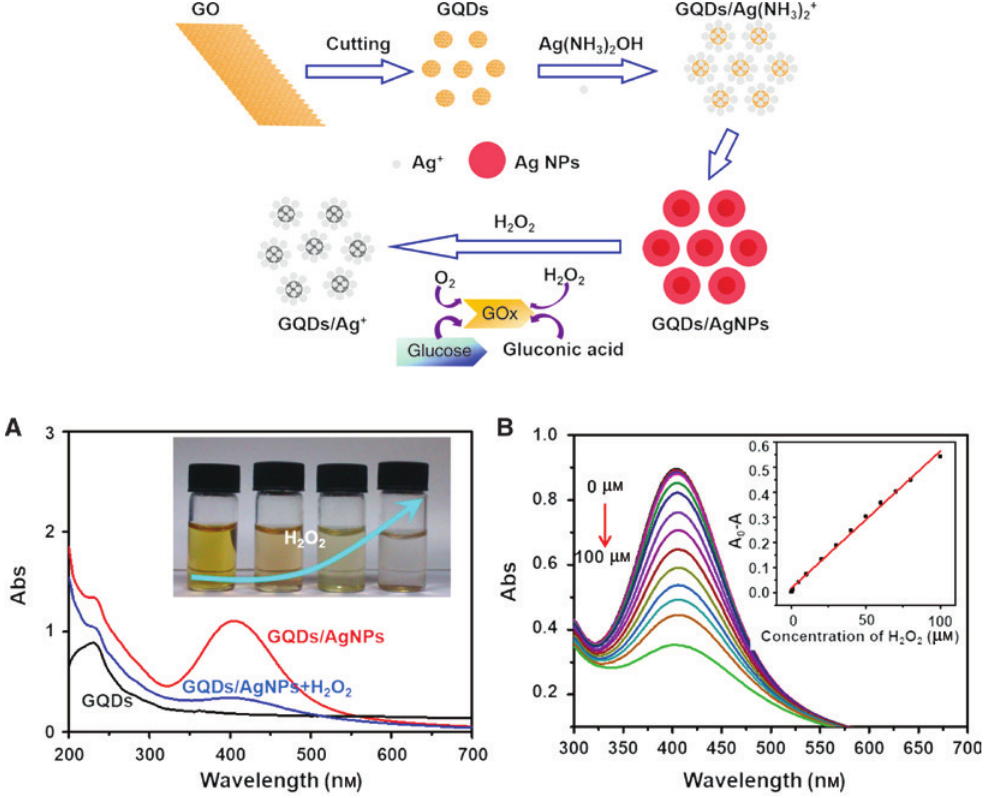
O and glucose based on color fading 2 2 O concentrations). (B) UV-Vis absorption spectra 2 2